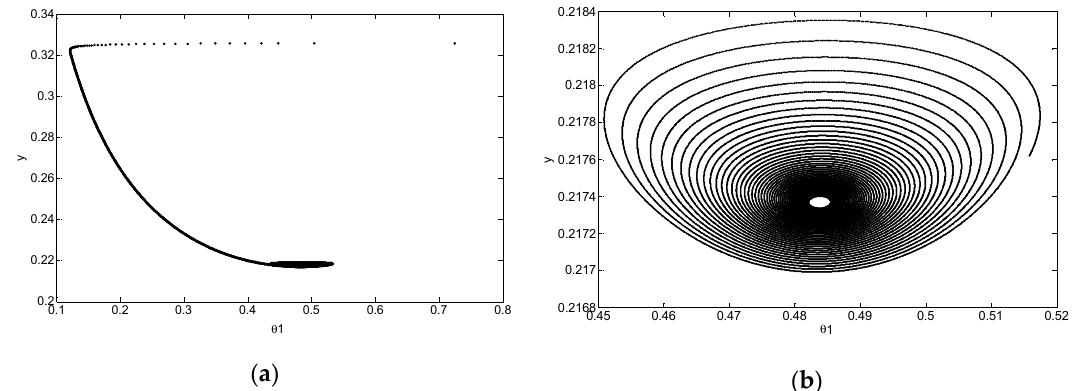
Figure 17. Superficial fractional coverage of carbon monoxide versus superficial density at 99.992 Pa, with θ 1 = 0.72525, θ 2 = 0.52275 and y = 0.32595, and time step = 2·10 − 4 s. ( a ) without zoom, ( b ) zoom on the spiral.